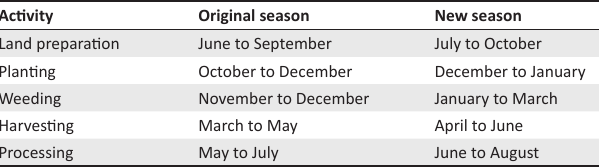
TABLE 2: Seasonal calendar for Zvimba District.